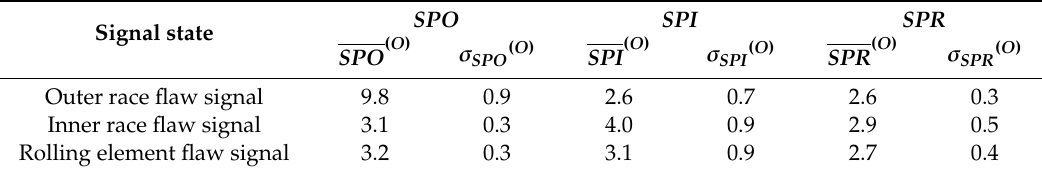
Table 7. SPx and σ SPx calculated in each state of CH3 for